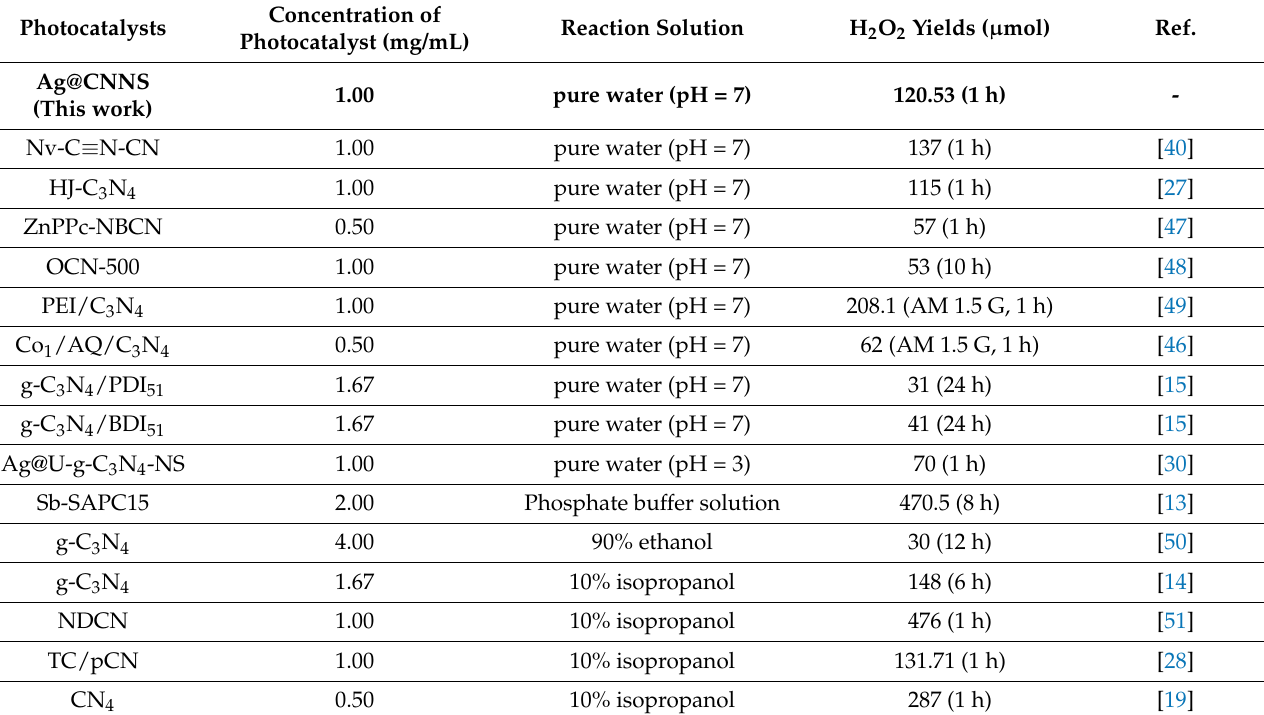
Table 1. Summary of the photocatalytic production of H 2 O 2 with g − C 3 N 4 − based photocatalysts.